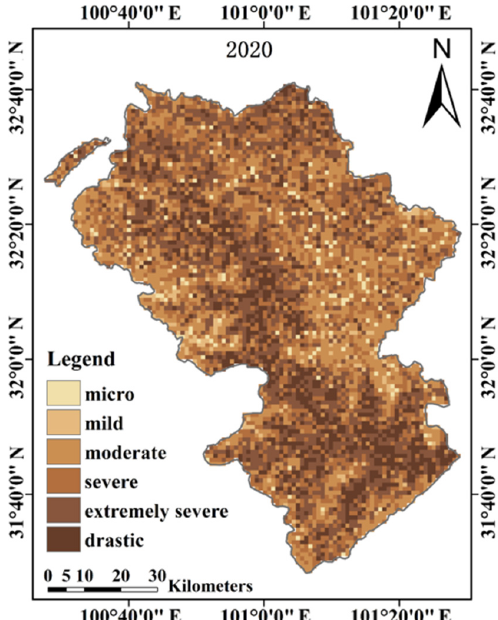
Figure 12. Land stress index of Rangtang County.